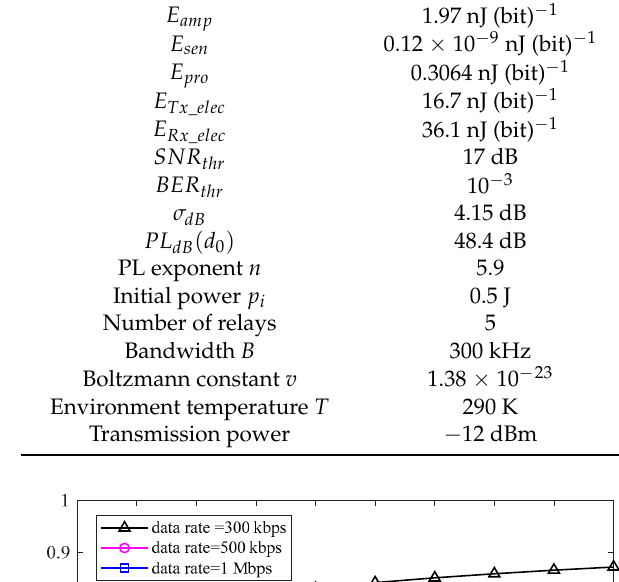
Table 2. Selected simulation parameters.